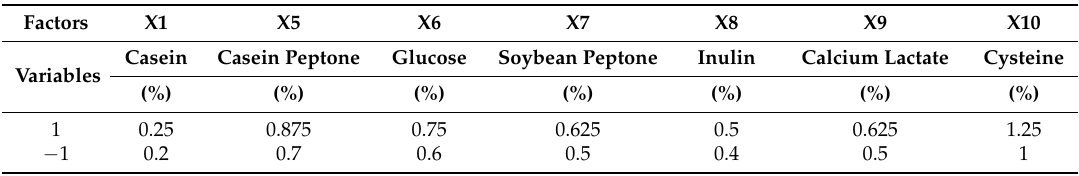
Table 1. Factors and coded levels of the Plackett–Burman (P–B) design for peptide production- promoting